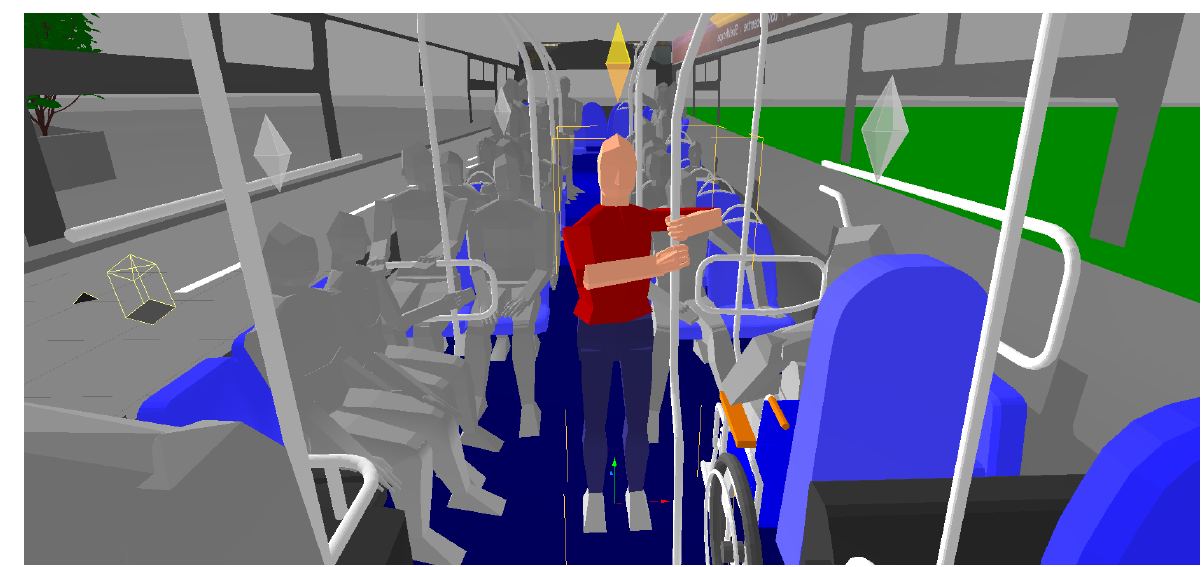
Figure 13. P13 moves forwards resulting a double handed grip of the left hand